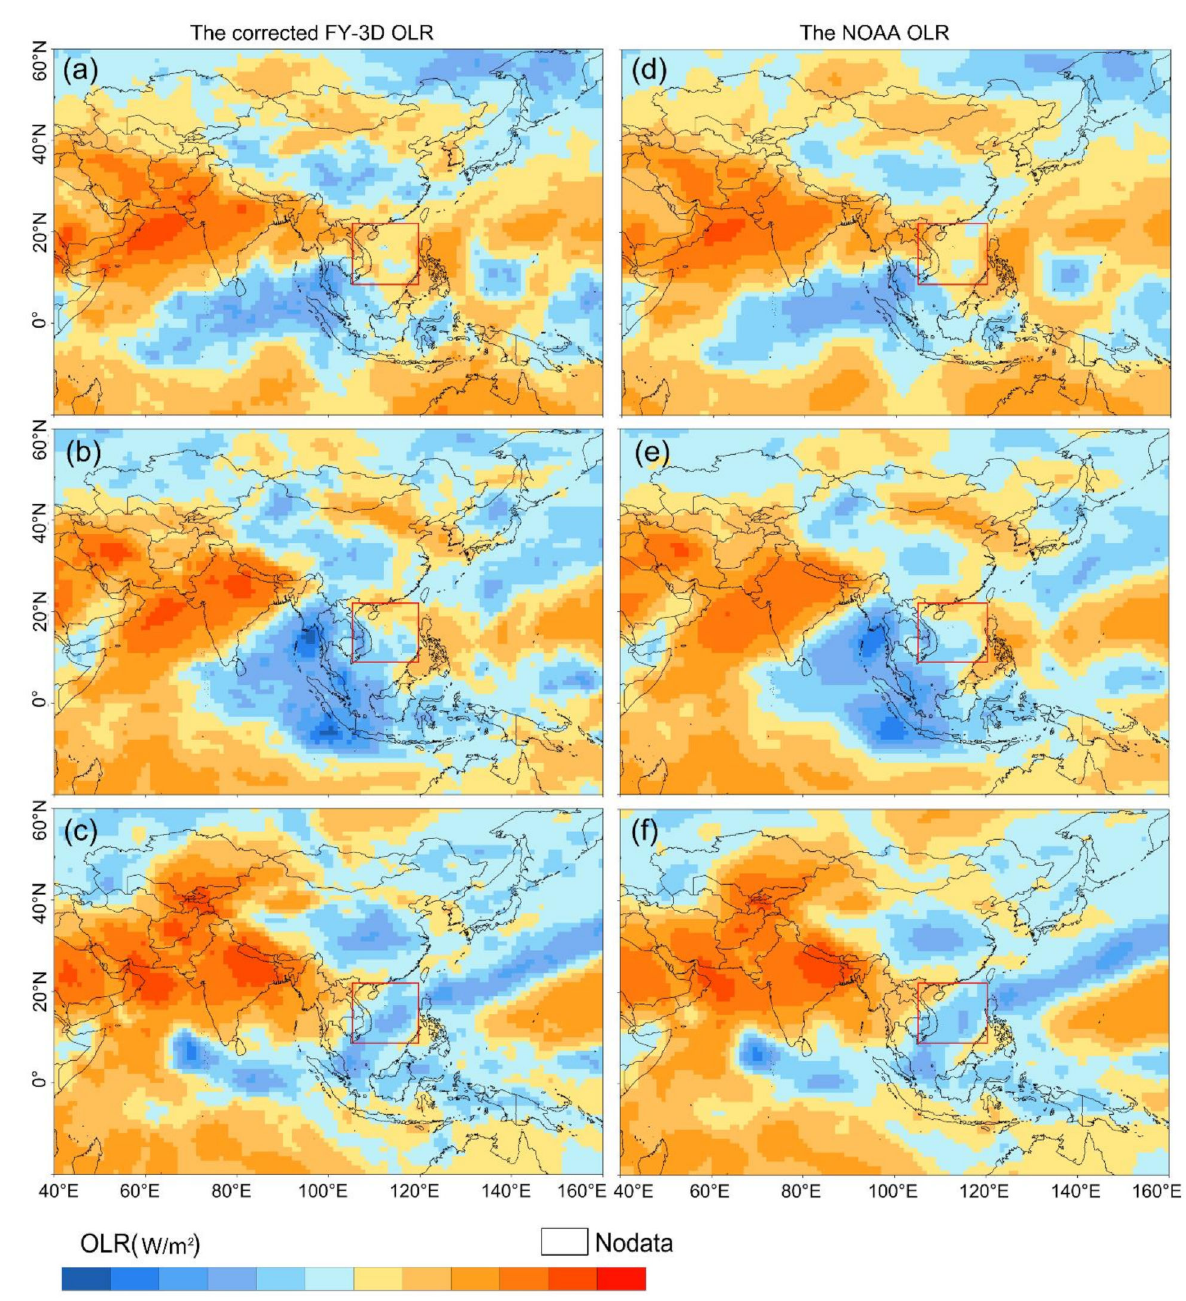
Figure 8. Spatial distribution of the pentad average of the corrected F_ OLR and N_ OLR before and after the onset of the South China Sea Summer Monsoon in Asia from the third to the fifth pentad of May 2020. ( a – c ) Pentad average of the corrected F_ OLR from the third to the fifth pentad of May 2020. ( d – f ) Pentad average of N_ OLR from the third to the fifth pentad of May 2020. The red box marks the region of 110 ◦ –120 ◦ E, 10 ◦ –20 ◦